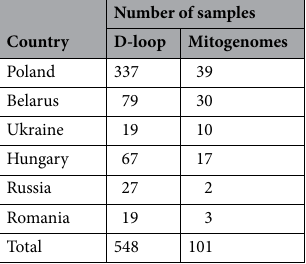
Table 1. Number of analysed wild boar tissue samples per country. Russia—European part only. See Fig. 1 for spatial distribution of